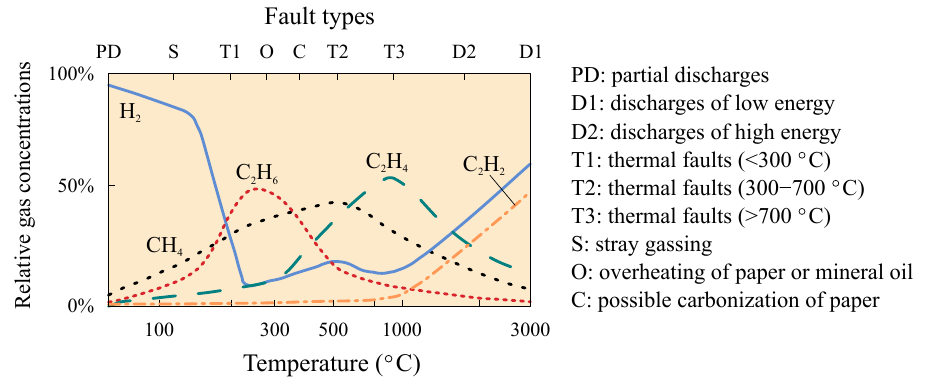
Figure 2. Gas generation based on temperature (reprinted with permission from CIGRE [5], c (cid:13)